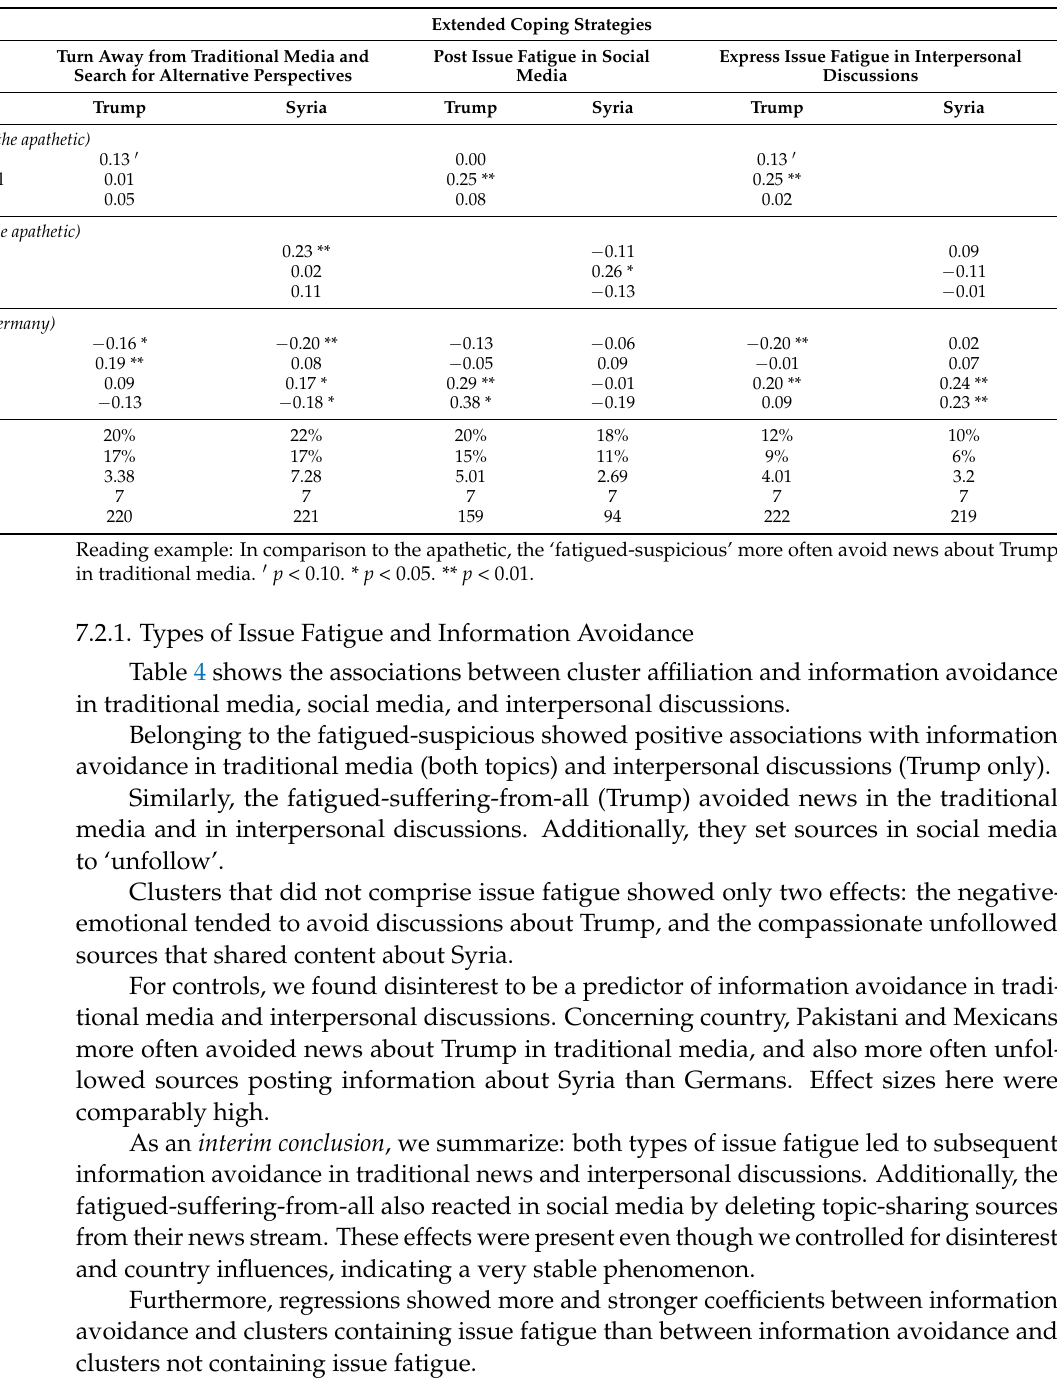
Table 5. The associations between issue fatigue clusters and extended coping—multiple linear regression analysis with categorical variables and baseline